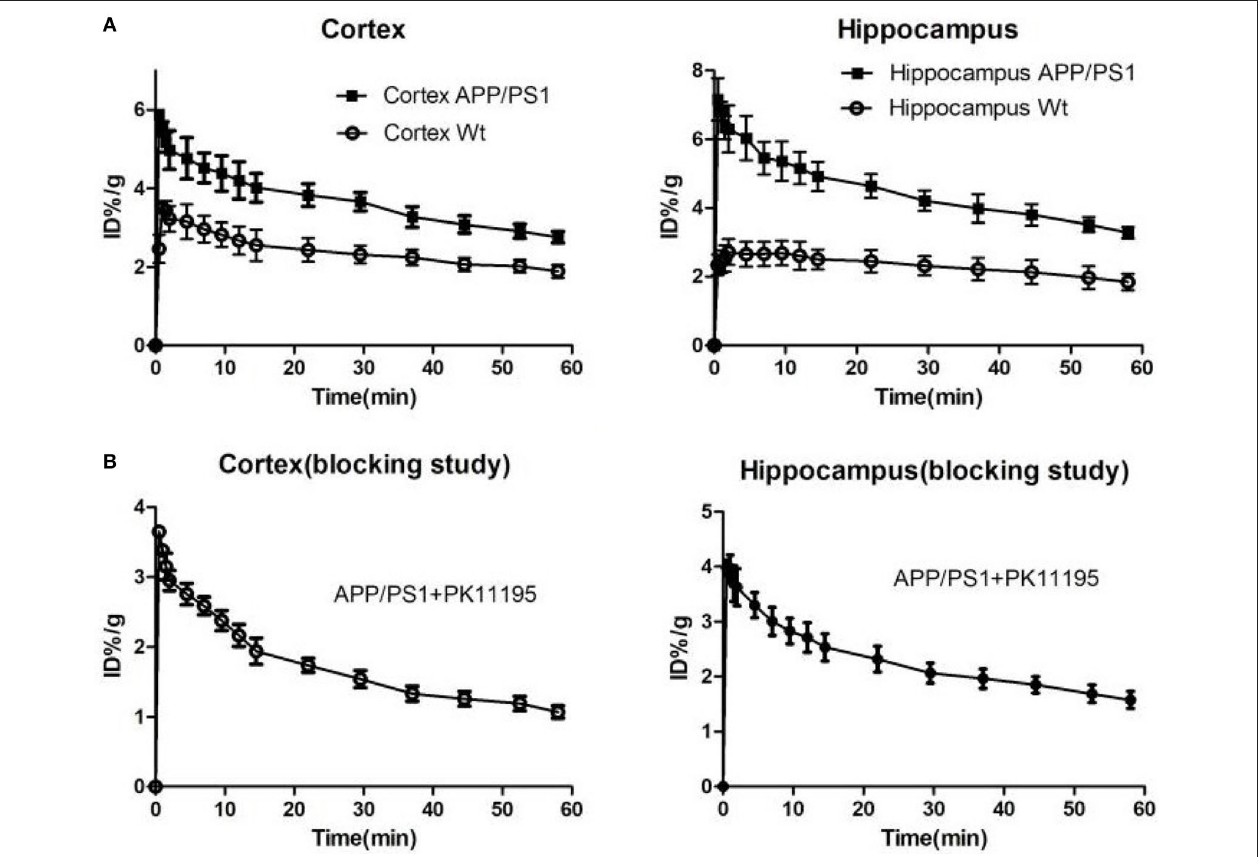
FIGURE 3 | (A) The time-activity curves (TACs) of [ 18 F]DPA714 accumulation in cortex and hippocampus of 12–13-months-old APP/PS1 ( n = 8) and Wt ( n = 8) mice using dynamic scan (60 min). (B) In blocking studies, the time-activity curves (TACs) of [ 18 F]DPA714 accumulation in cortex and hippocampus pre-treated